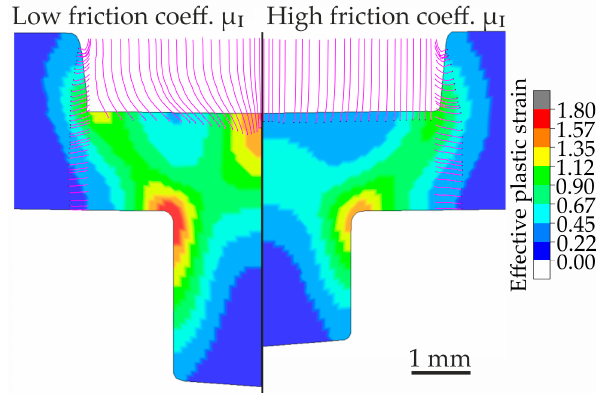
Figure 11. The comparison of a low and high friction coefficient µ I (c.f. Table 1) between the punch and steel blank during pin